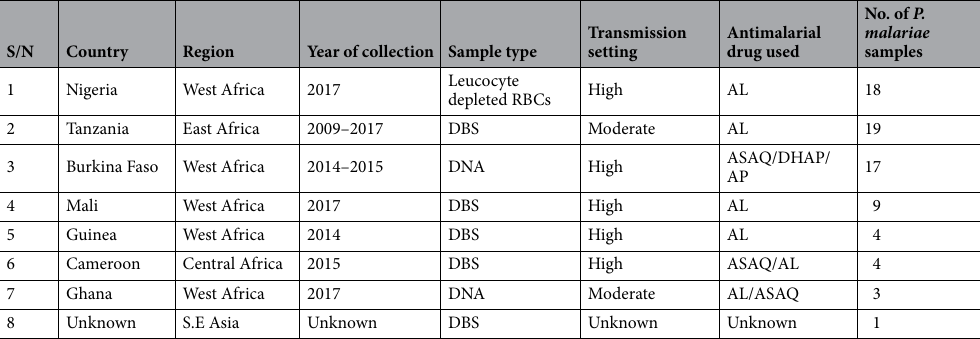
Table 1. Distribution of P. malariae samples from endemic countries. AL Arthemeter-Lumefantrine, ASAQ Artesunate-Amodiaquine, DHAP Dihydroartemisin piperaquine), AP